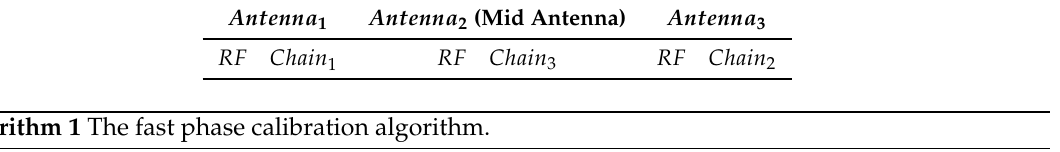
Table 1. The mapping relationship between the logical RF chains and the antenna ports.